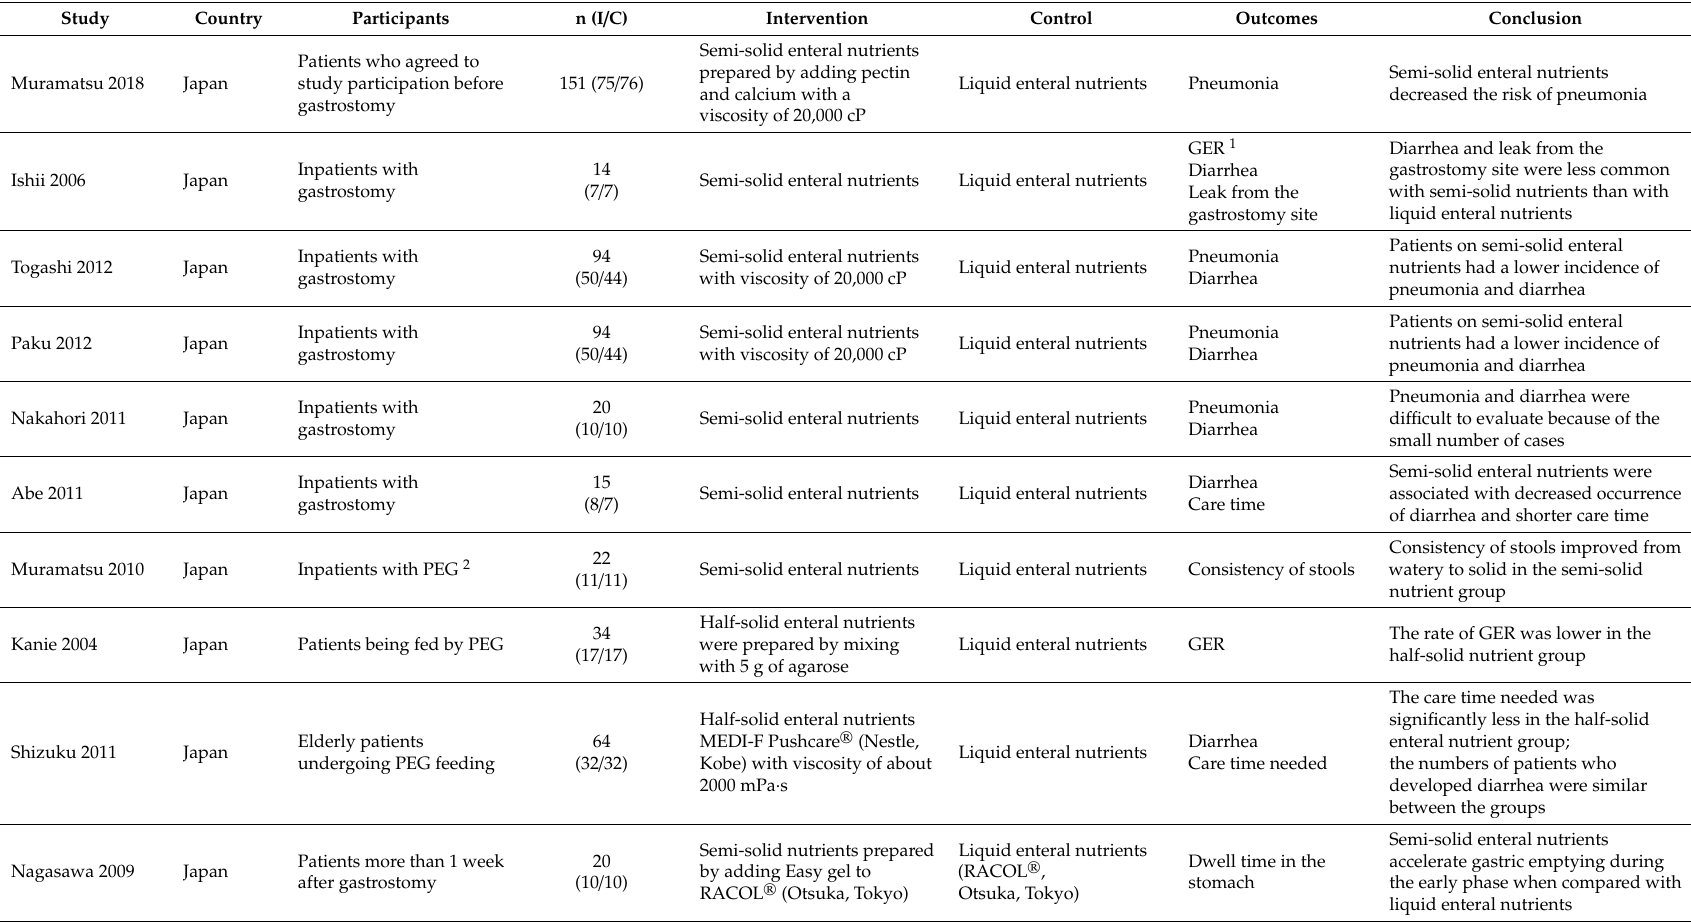
Table 1. Characteristics of included